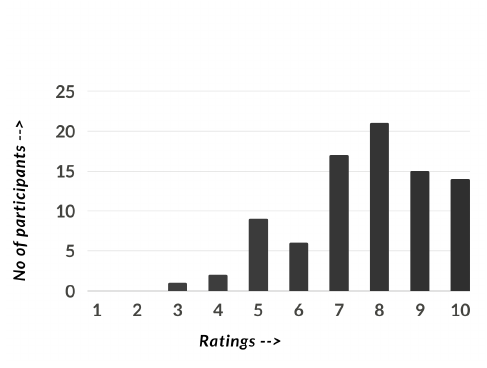
Figure 3: Statistics of survey